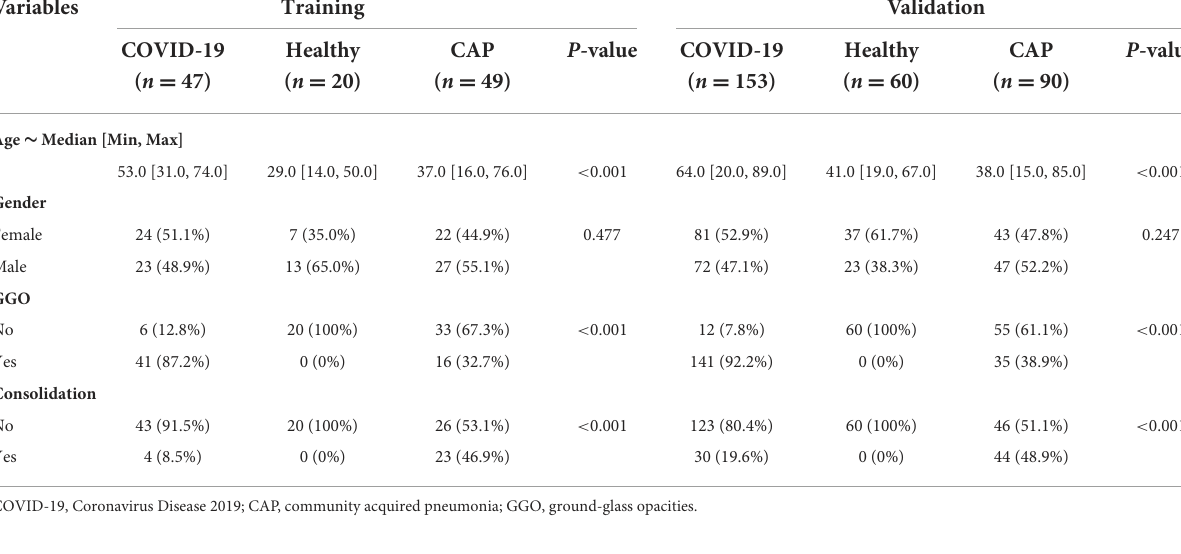
TABLE 1 Characteristics of participants included in this study.